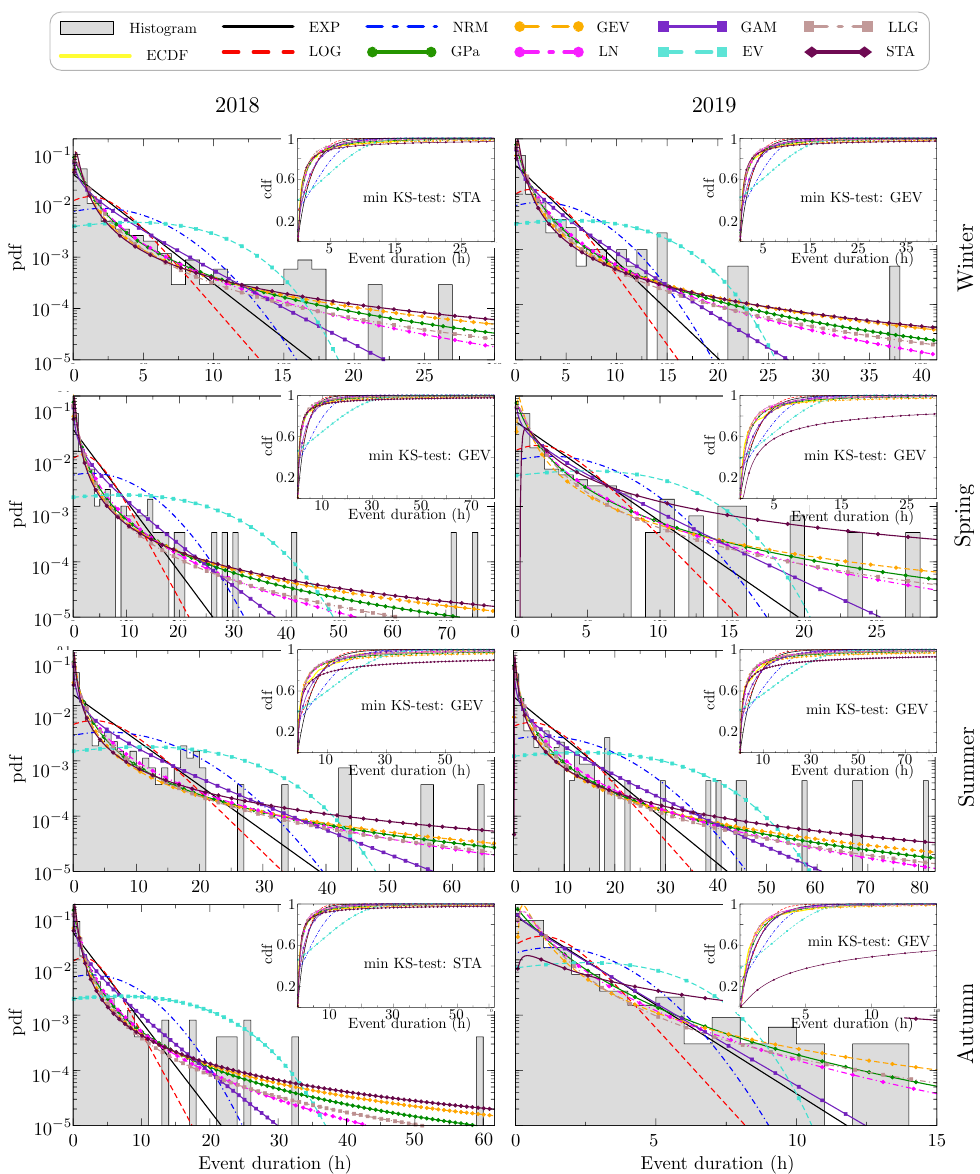
Figure 5. Probability density functions of fog events over time for the Maximum Likelihood approach fixing the threshold to 2000 m. The CDF is located in the insets. Each row corresponds to a season and each column to a